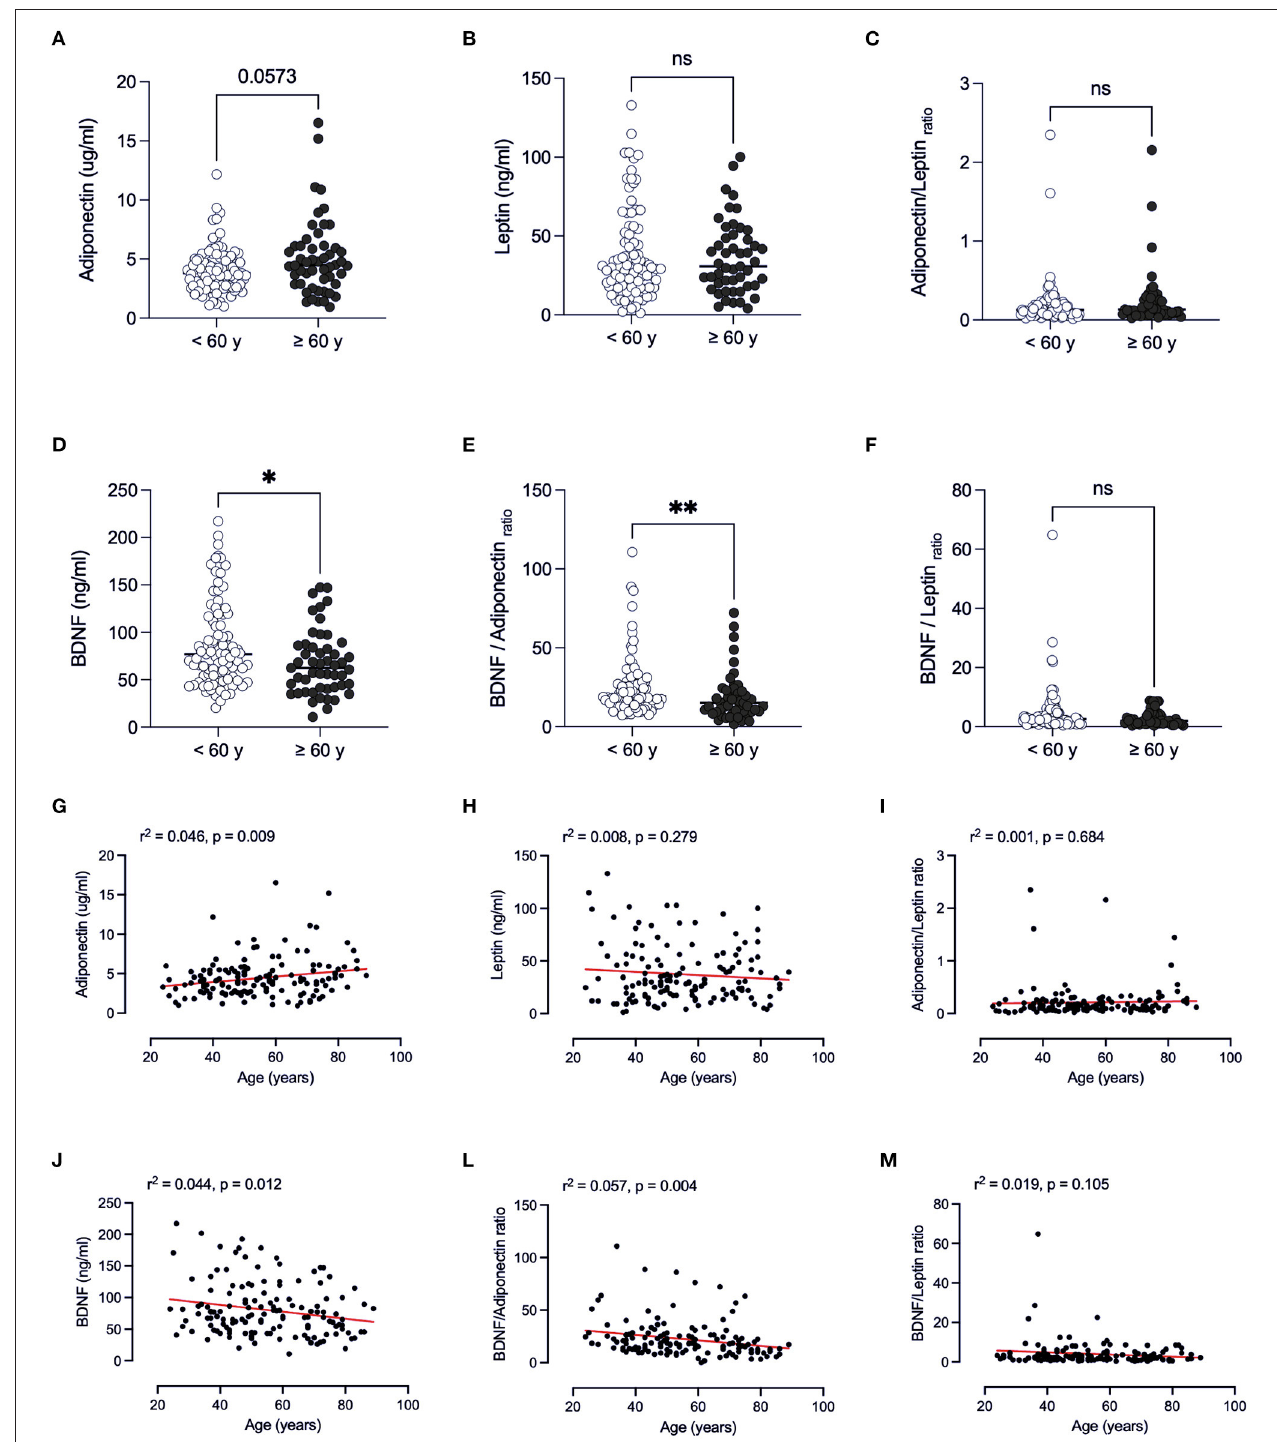
FIGURE 3 | Comparison of adipose-derived hormone levels between age ranges ( < 60 years vs. ≥ 60 years) of patients with Covid-19. Values expressed as median of adiponectin (ug/ml) (A) , leptin (ng/ml) (B) , adiponectin/leptin ratio (C) , BDNF (ng/ml) (D) , BDNF/Adiponectin ratio (E) , BDNF/Leptin ratio (F) , BDNF / Adiponectin/Leptin ratio (G) were compared between two groups. Dashed box presents linear regression curve of adiponectin (G) , leptin (H) , adiponectin/leptin ratio (I) ; BDNF (J) , BDNF/Adiponectin ratio (L) , BDNF/Leptin ratio (M) as dependent variable (Y axis) with age as independent variable (X axis). Significance: * p < 0.05; ** p < 0.01.